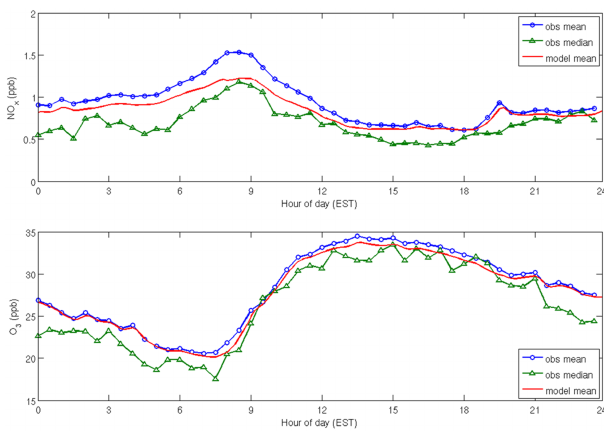
Fig. 8. Observed August mean (blue circle) and median (green tri- angle) diurnal cycle in NO x , MO and O 3 mixing ratios above the canopy at 34m. Also shown are the simulated August mean (red line) diurnal mixing ratios.